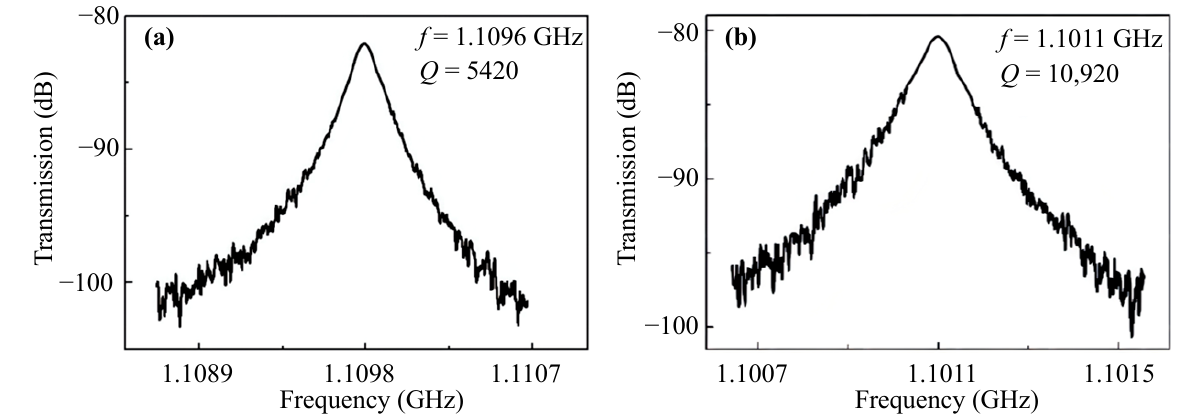
Figure 11. The spectra of the 4th WEM resonators supported by the straight tethers ( a ) and the combined tethers ( b ). Table 5. The comparison between the reported GHz resonators and this work.